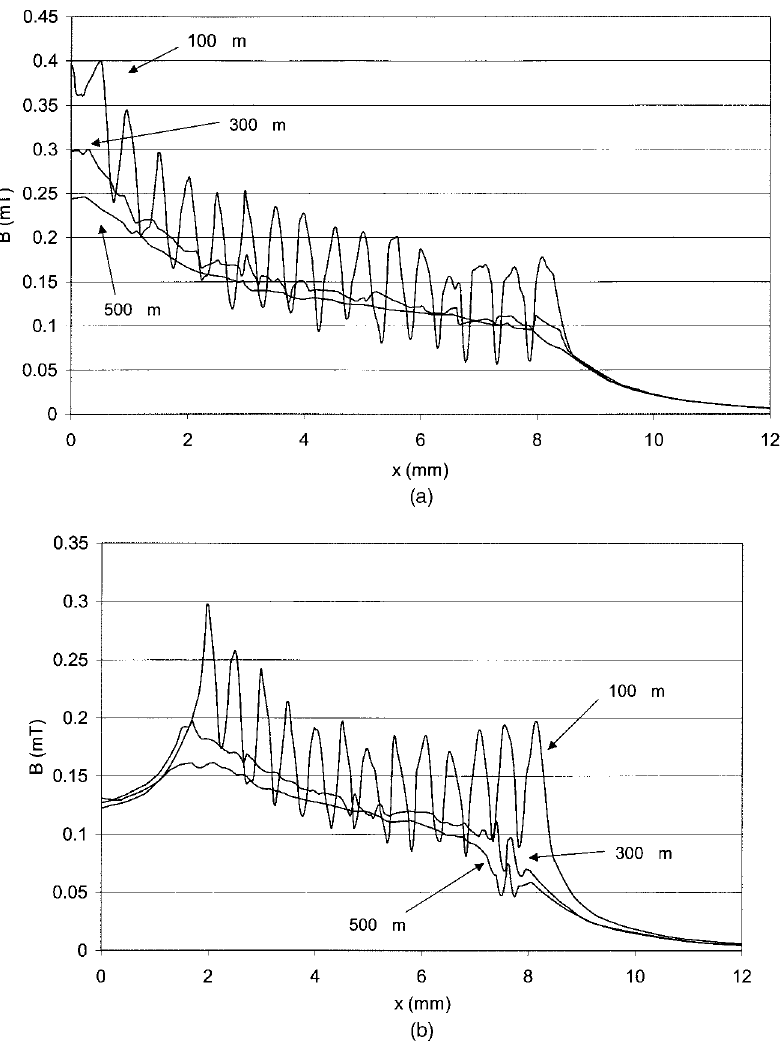
FIGURE 2 Magnitude of the magnetic flux density B as a function of x along lines defined as y ¼ 0 and z ¼ d with d reported as parameter. In (a) the magnitude of the spiral of Figure 1(a) and in (b) that of Figure